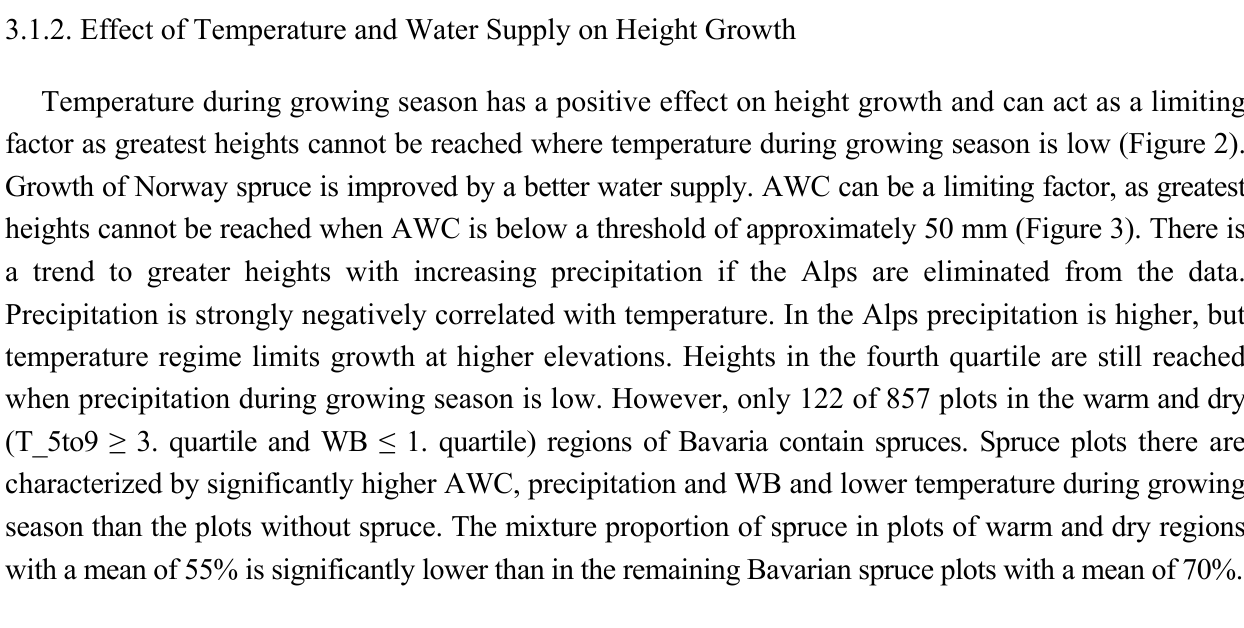
Figure 2. Boxplot of temperature during growing season for the quartiles of scaled height distribution; mean temperature during growing season for the fourth quartile is significantly higher than for the first and second